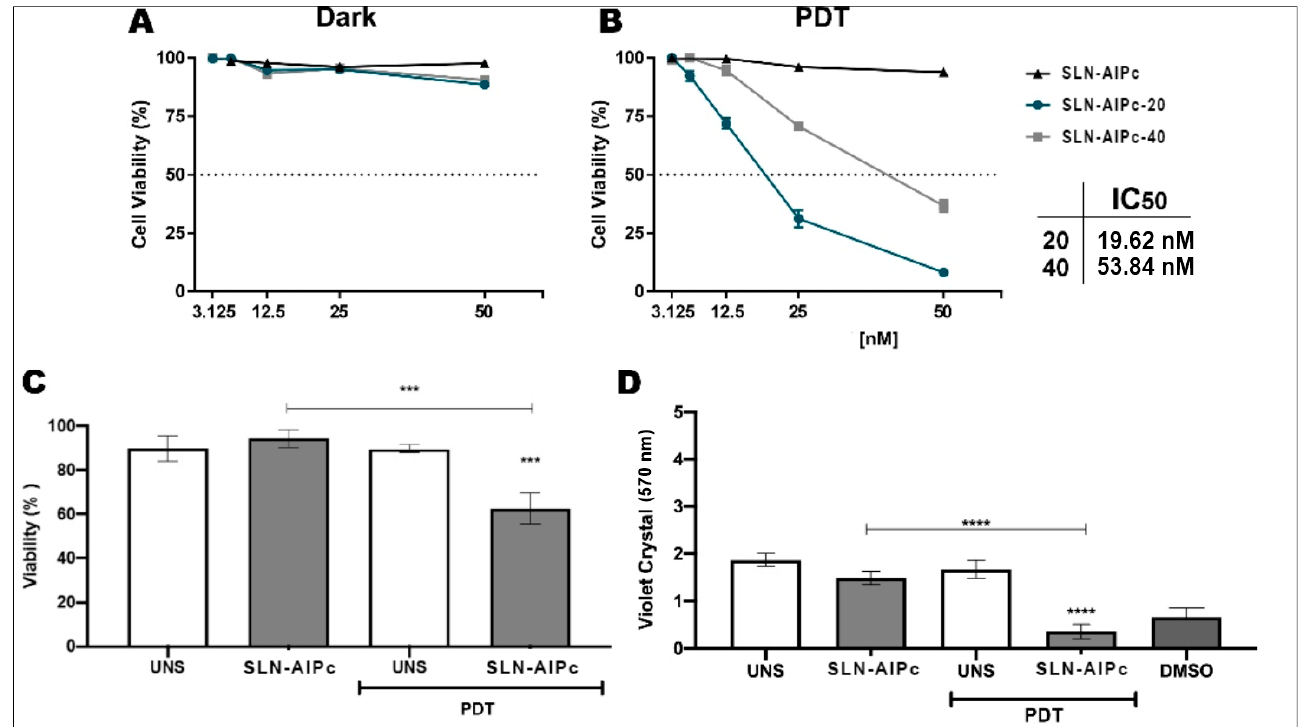
Figure 13. Cellular viability of B16-F10 cells treated with SLN-AlPc. The percentage of B16-F10 cell viability was calculated at different concentrations of SLN-AlPc treatment ( A , B ). The percentage of B16-F10 cell viability was calculated at different treatment conditions using propidium iodide ( C ). The absorbance of violet crystal was calculated under different treatment conditions to evaluate the cell death ( D ) *** p < 0.001 and **** p < 0.0001 compared to control.